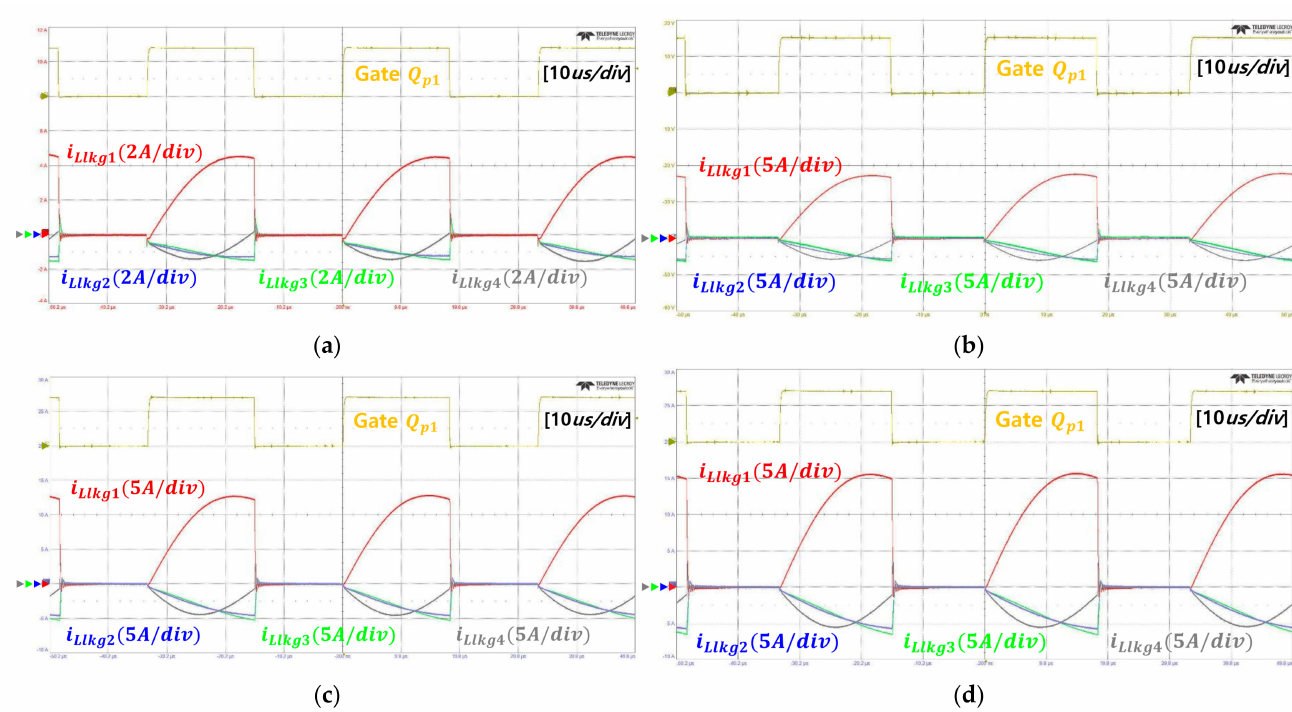
Figure 11. Experimental key waveform at 8 V input, 30 V output. ( a ) 20% load. ( b ) 50% load. ( c ) 80% load. ( d ) 100% load conditions.